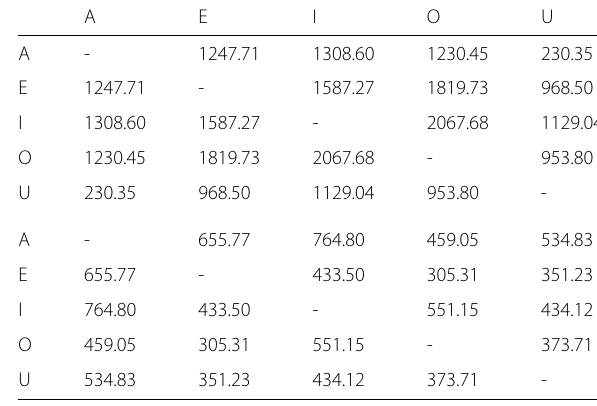
Table 1 χ 2 metric for the histograms in Fig. 5, without (top)